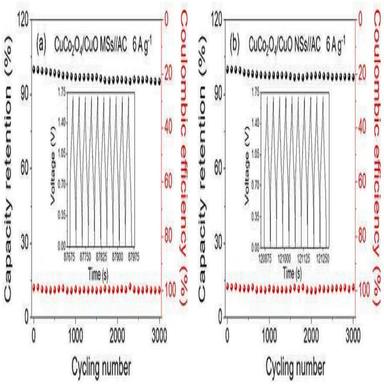
The cycling performance and Coulombic efficiency of (a) CuCo2O4/CuO MSs//AC HSC and (b) CuCo2O4/CuO NSs//AC HSC over 3000 cycles at 6 A g− 1 , and the insets showed the last ten GCD curves.